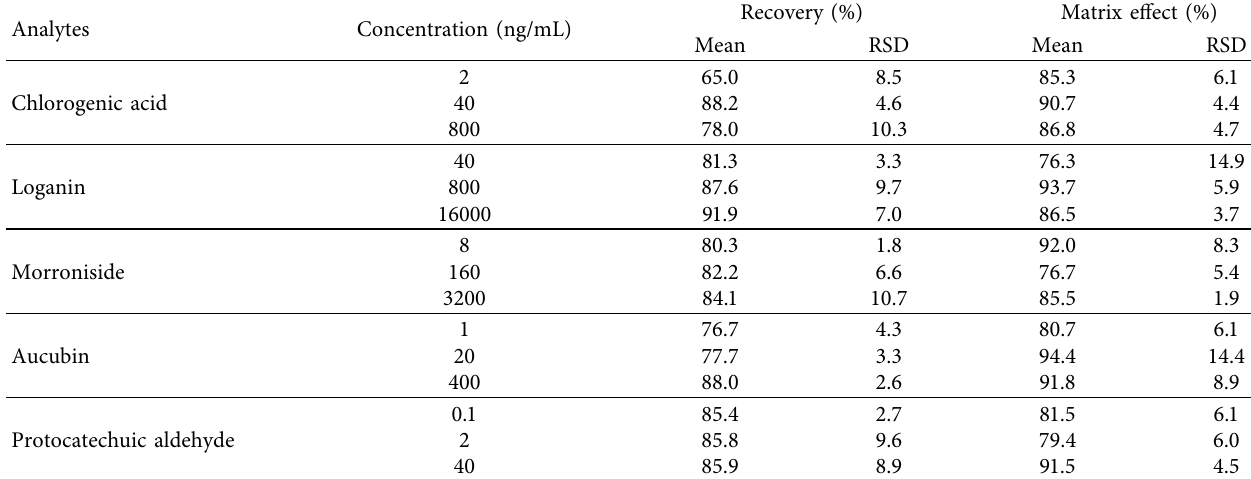
Table 5: Recover and matrix efect of 5 analytes in rat plasma ( n � 6).